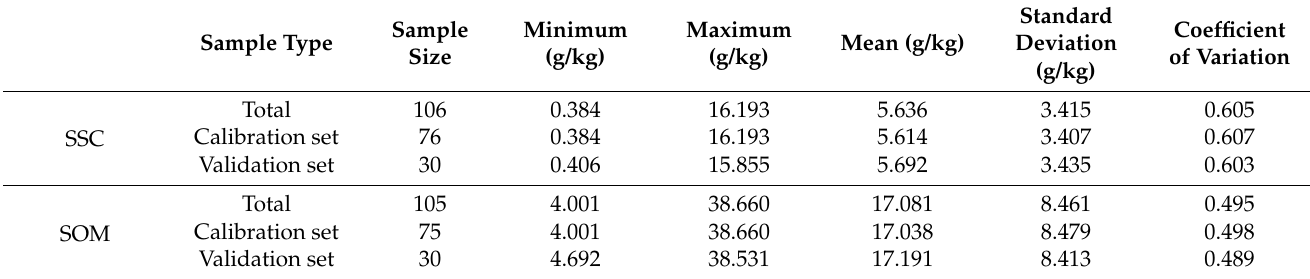
Table 4. Soil salt content (SSC) and soil organic matter (SOM) characteristics among soil